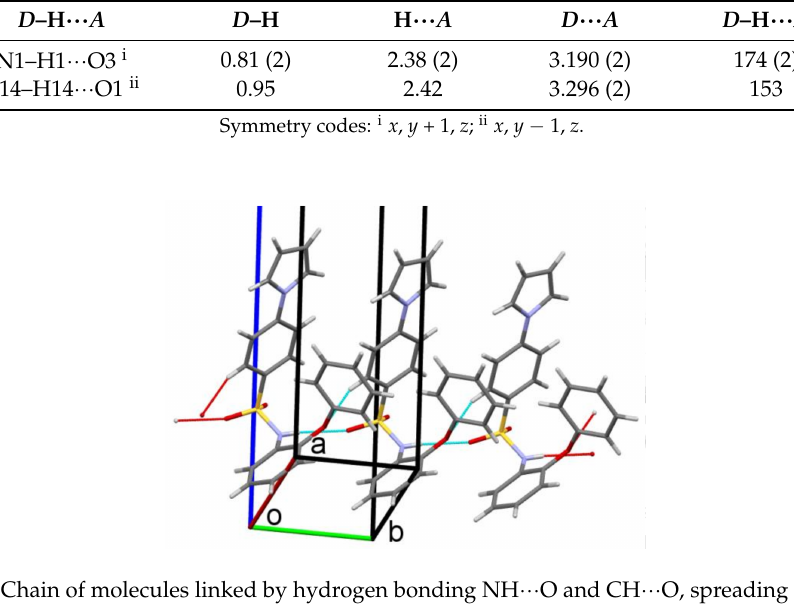
Figure 4. Chain of molecules linked by hydrogen bonding NH ··· O and CH ··· O, spreading along the b axis with no internal symmetry.